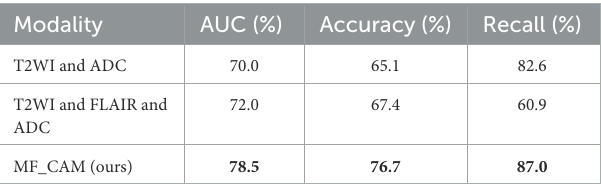
TABLE 2 Comparison of classification performance based on different modalities.